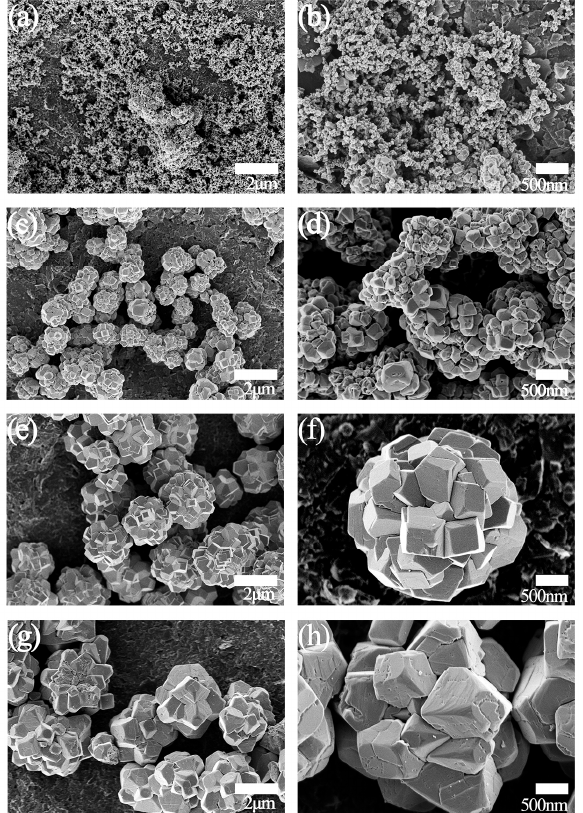
Figure 2. Field emission scanning electron microscopy images of the samples synthesized for 12 h at different NaF concentrations: ( a , b ) T1; ( c , d ) T2; ( e , f ) T3; ( g , h ) T4.